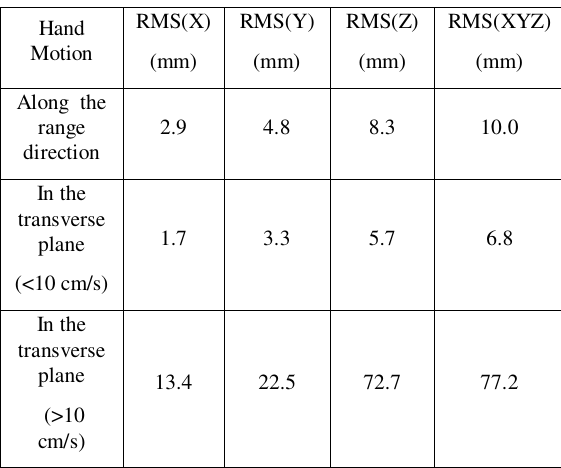
Table 1: Accuracy of hand motion tracking with variation in